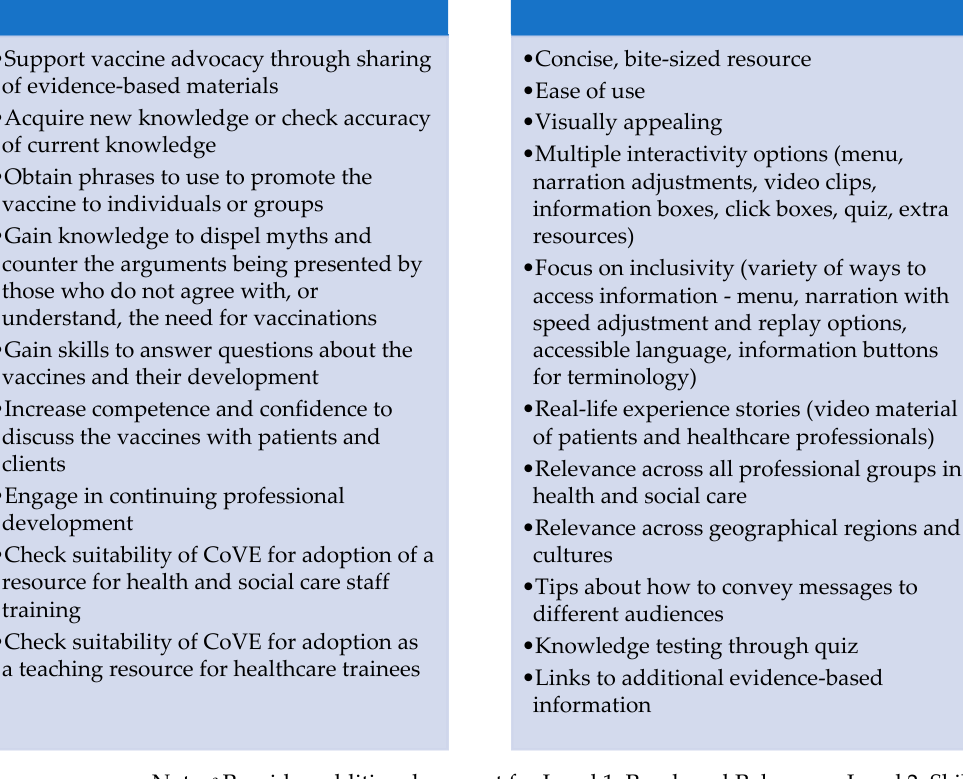
Figure 6. Reasons for access and most valued training elements.